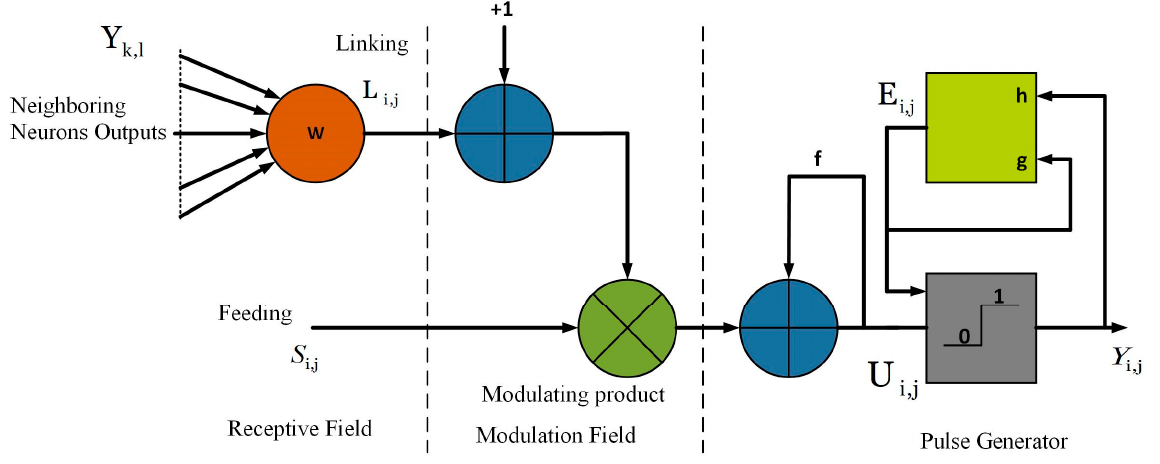
Figure 6. Flow diagram of the SCM model.